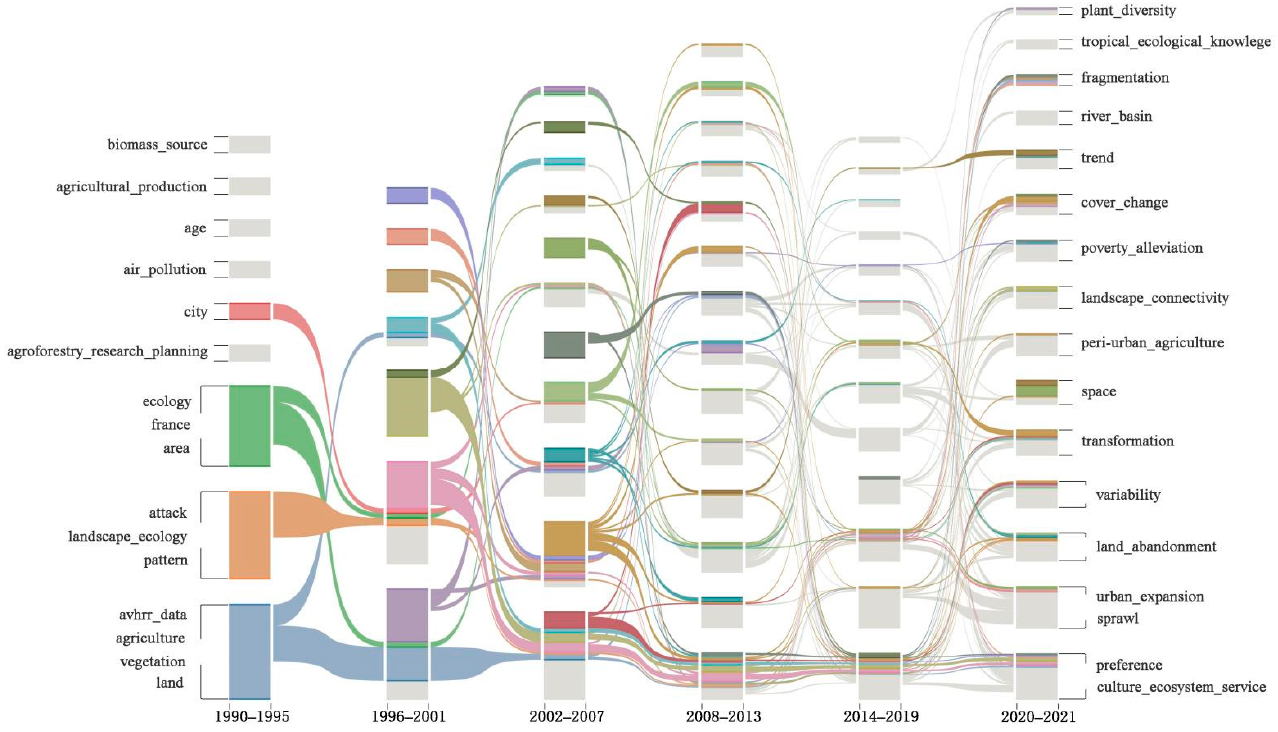
Figure 11. Alluvial diagram of research hotspots and progression changes.